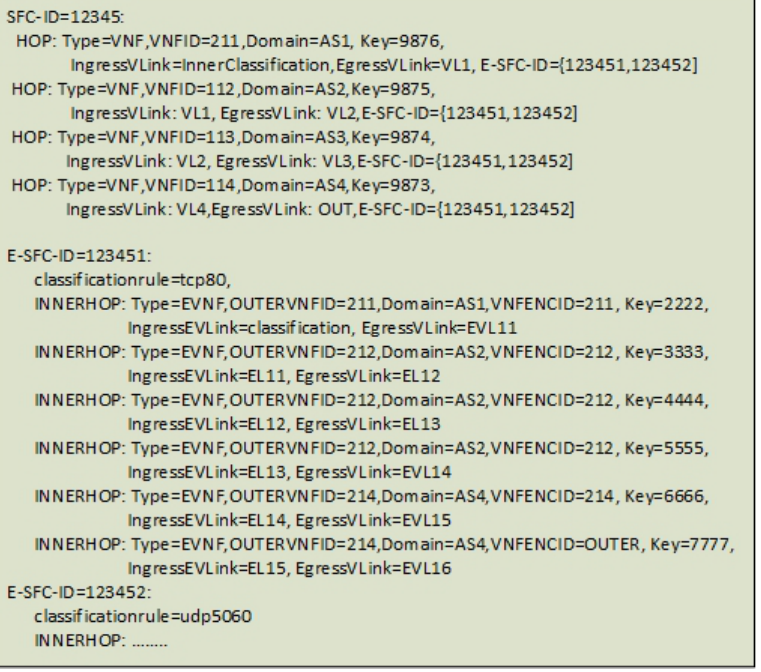
Figure 15. SFC provisioning message from the orchestration